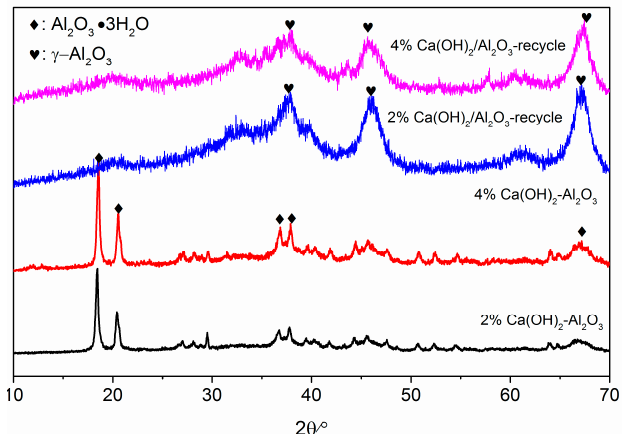
Figure 6. XRD patterns of fresh and used catalysts. Table 6. Typical properties of catalysts.